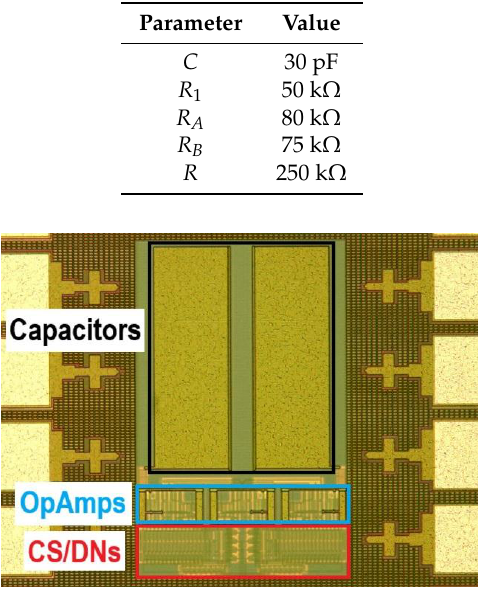
Table 1. Oscillator design parameters.